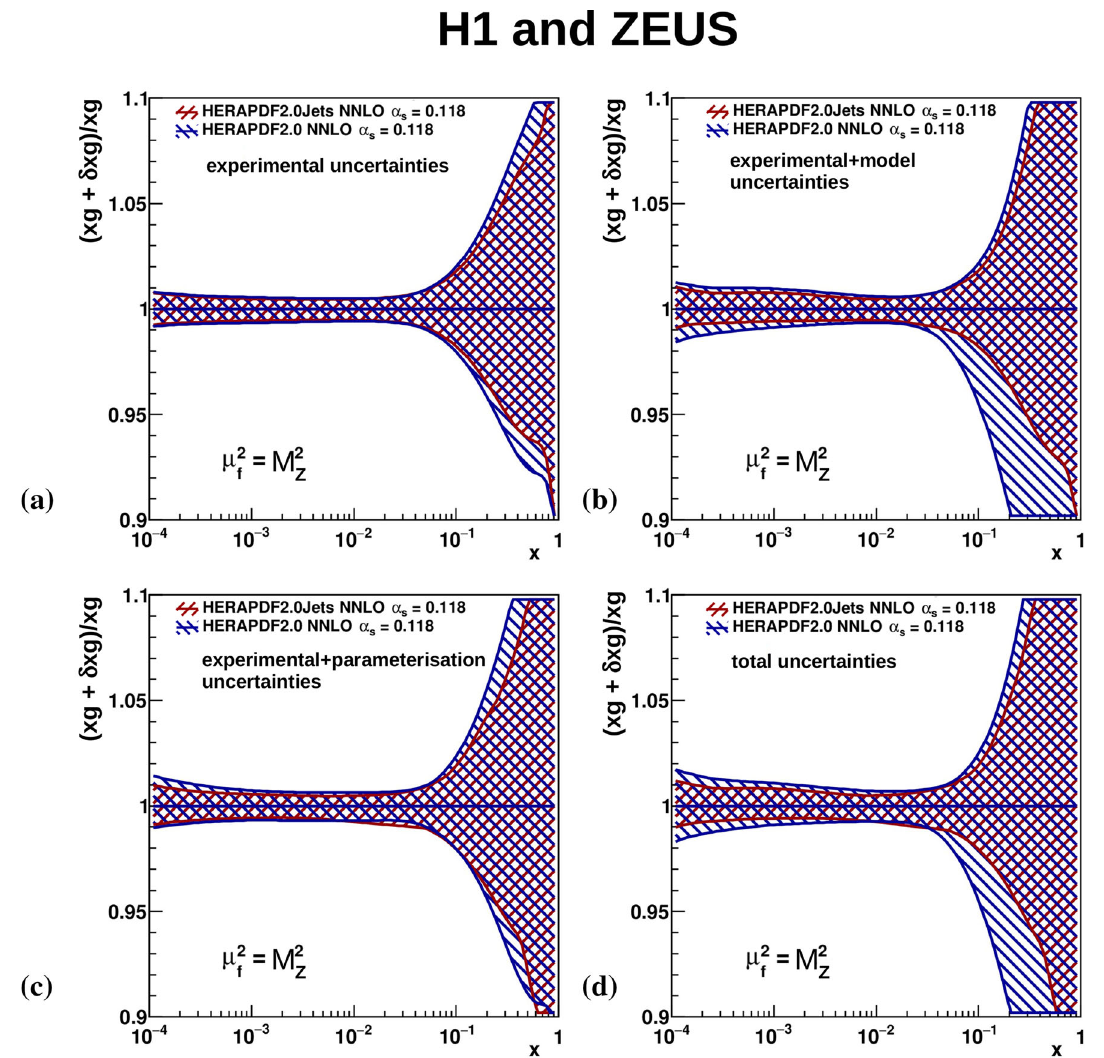
Fig. 9 Comparison of the normalised uncertainties on the gluon (fit), b experimental plus model, c experimental plus parameterisation, PDFs of HERAPDF2.0Jets NNLO and HERAPDF2.0 NNLO, both d total uncertainties. The uncertainties on both gluon PDFs are shown ) = 0 . 118 and at the scale μ 2 = M 2 for α s ( M 2 as differently hatched , for a experimental Z Z f